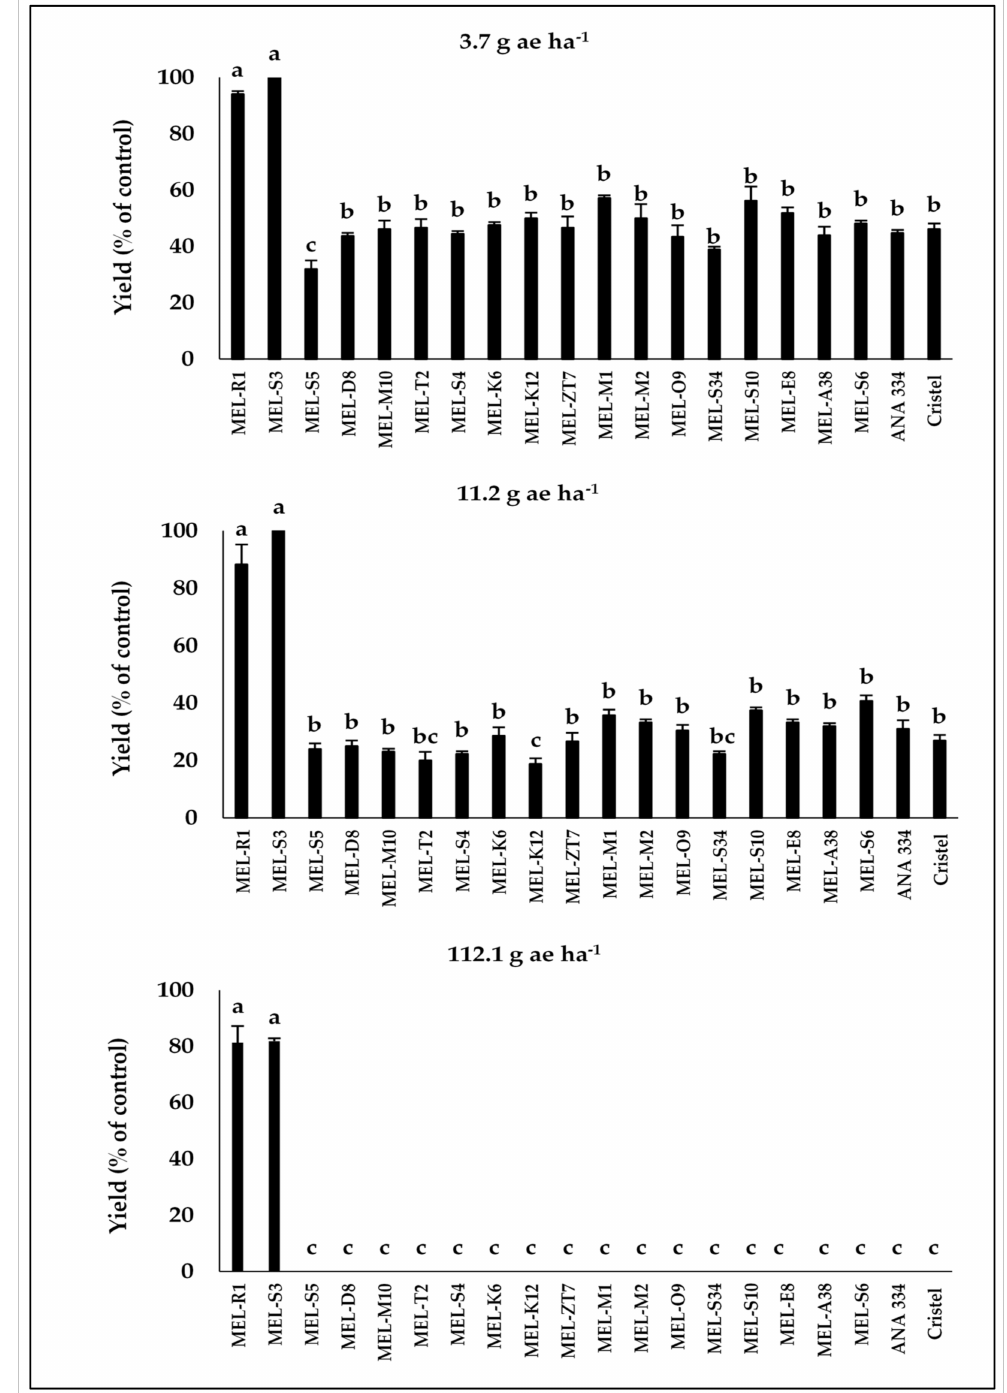
Figure 5. The fruit yield production compared to untreated control in melon accessions and commercial cultivars in response to different drift rates of 2,4-D during 2020. Means in each chart followed by different letters are significantly different at p ≤ 0.05 using LSD